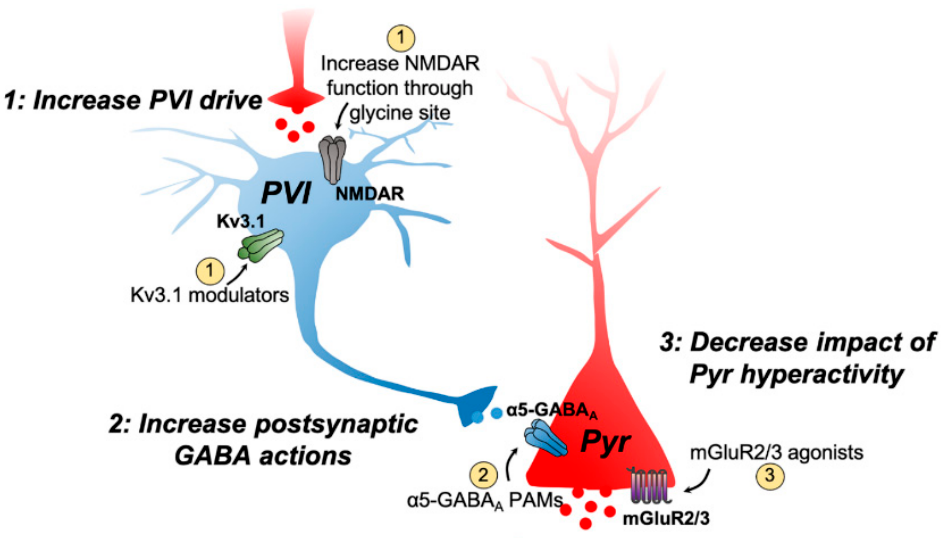
Figure 2. Targeting the dysregulation of excitatory–inhibitory balance in SCZ include compounds that may compensate for the functional loss of PV interneurons (PVI) and attenuate the potentially increased activity of pyramidal (Pyr) neurons as well as the resulting increase in glutamate release. A hypofunction of NMDA receptors on PVI is proposed to underlie SCZ symptoms. ( 1 ) Compounds that facilitate NMDA receptor activity without triggering excitotoxicity, such as compounds that act through the glycine site, have the potential to increase PVI drive. A further approach that could normalize the functional loss of PVI is the modulation of Kv3.1 potassium channels on these cells. These channels play an important role in regulating PVI activity by allowing these cells to fire at high frequency. ( 2 ) Another approach that could compensate for decreases in PVI functionality is to increase postsynaptic GABA actions. One target that has shown some promise is the GABA A receptor containing the α 5 subtype ( α 5-GABA A ). ( 3 ) A decreased PVI inhibition of pyramidal neurons leads to a greater glutamate release. Therefore, another target is the use of agents that decrease presynaptic glutamate release, such as group II metabotropic glutamate receptor (mGluR2/3) agonists have attracted great interest as a novel treatment for SCZ. A further approach that could potentially normalize the functional loss of PV inter- neurons would be the modulation of Kv3.1 potassium channels on these cells. The Kv3.1